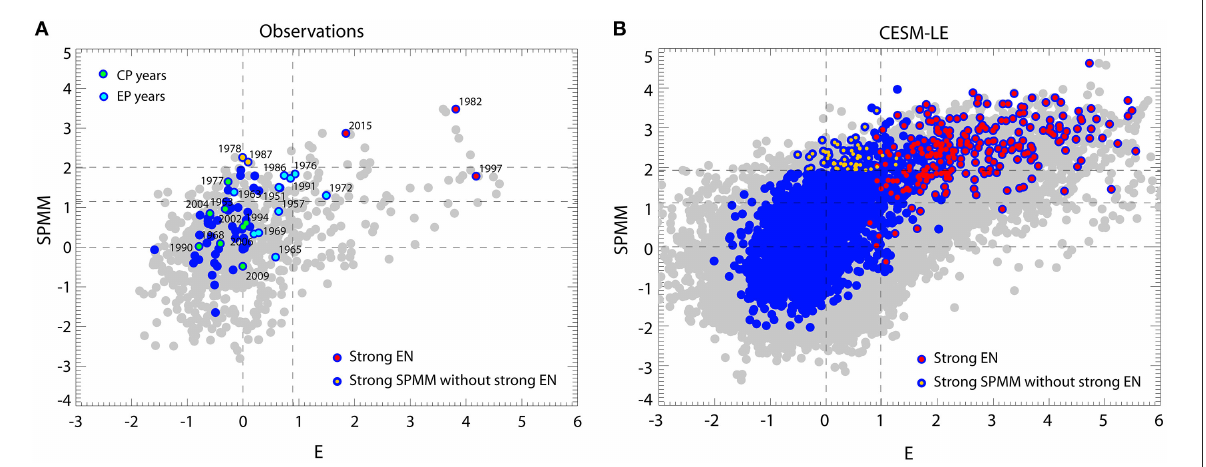
FIGURE4 Scatterplot between SPMM and the E indices in the (A) observations and (B) the CESM-LE. Gray dots correspond to the monthly mean indices phase-shifted by 10 months (E ahead SPMM). The blue dots correspond to the DJF E index and the maximum value of the SPMM index between June and February. The inner red and orange dots indicate the strong El Niño events (based on the DJF NINO34) and the strong SPMM events without preceding strong El Niño, respectively. In (A) , we also indicate the CP and EP El Niño years with their dates. Note that 1978 is not an El Niño year. The dashed horizontal line indicates the one and 1.75 time the standard deviation of the SPMM index (max. value over June-Feb), while the dashed vertical lines indicate the value of the standard deviation of the DJF E